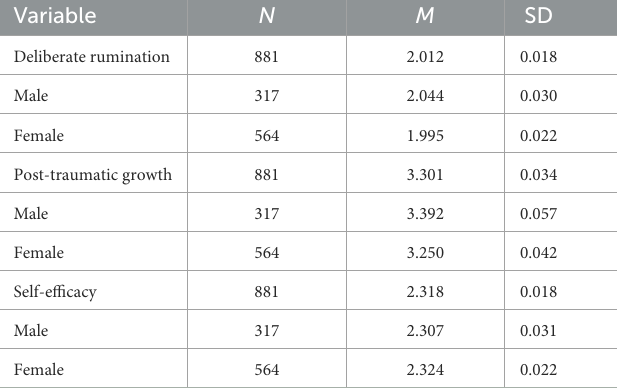
TABLE 1 Mean scores and standard deviations for variables, according to